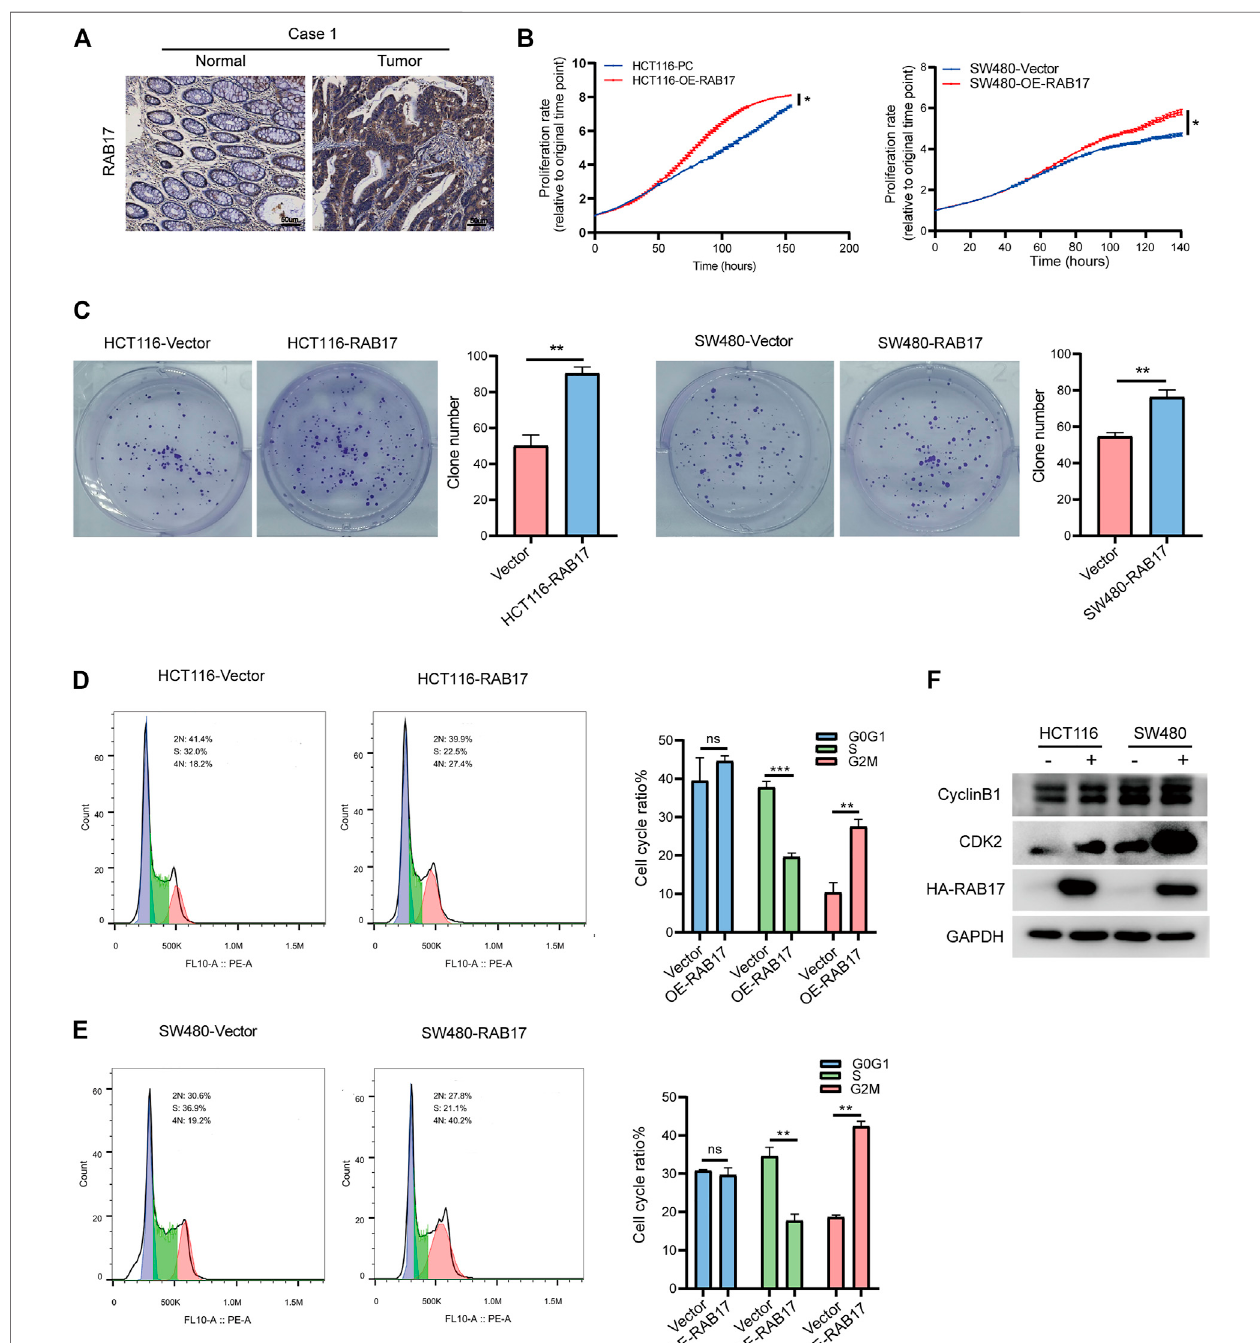
FIGURE 7 | Overexpression of RAB17 promotes cell proliferation of CRC. (A) Immunohistochemical staining of patients with colorectal cancer. (B) Incucyte assay revealed cell proliferation in HCT116 cells and SW480 cells. (C) Overexpression of RAB17 analyzed the colony-forming ability of HCT116 cells and SW480 cells. (D – E) Overexpression of RAB17 analyzed cell population both in HCT116 cells (D) and SW480 cells (E) by fl ow cytometer. (F) Overexpression of RAB17 analyzed the protein levels of CDK2 and cyclin B1 in the HCT16 cells and SW480 cells. * p < .05, ** p < .01, *** p < .001.